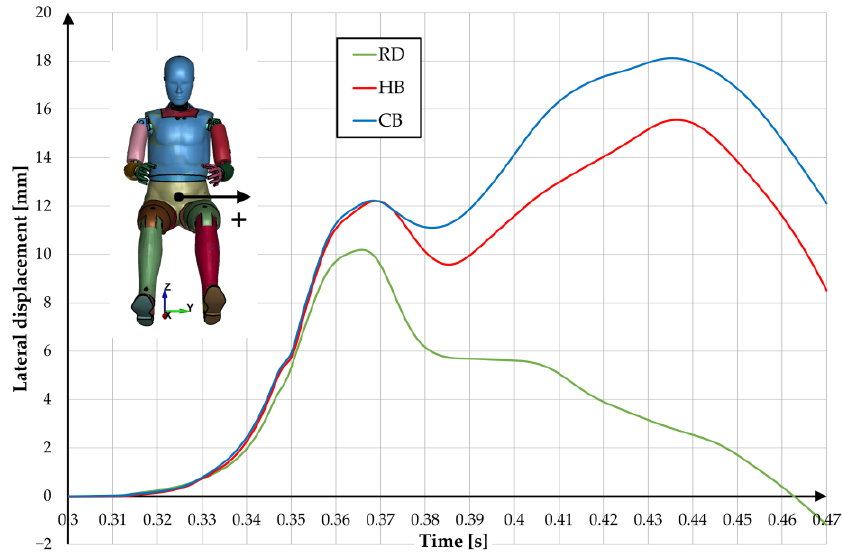
Figure 8. Lateral displacement of dummy H-point.